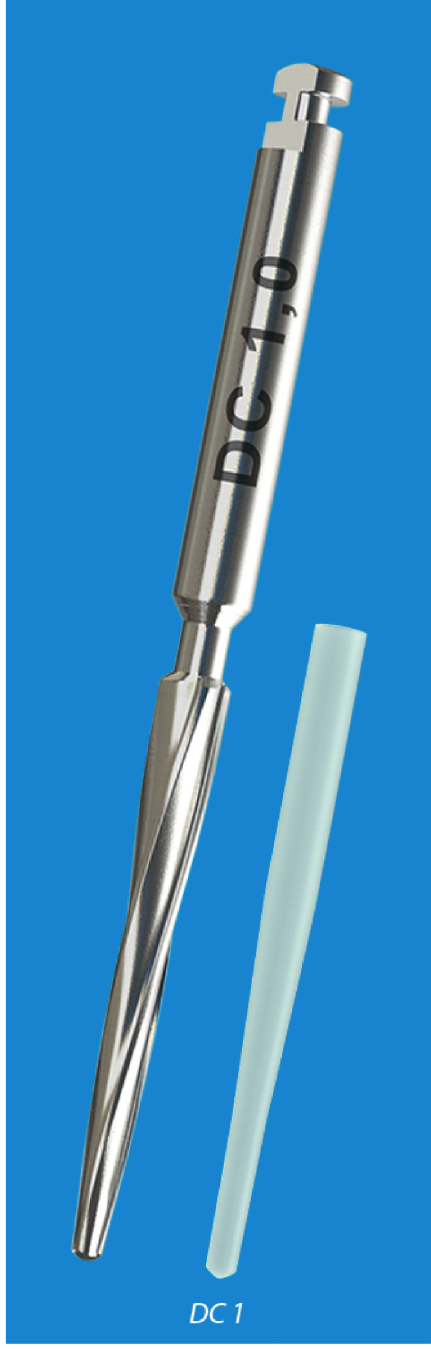
Figure 1: White post DC #1 and corresponding drill. Source: photo courtesy of the FGM dental group product image